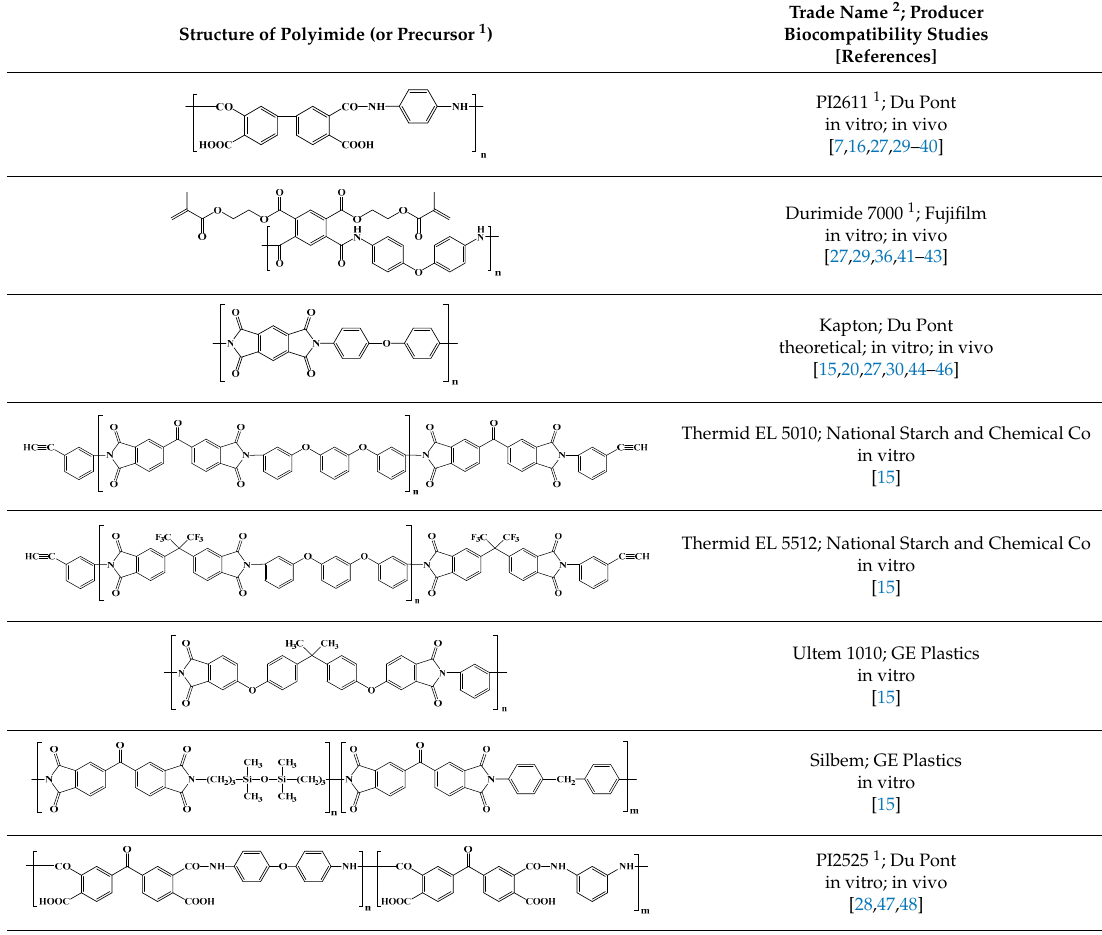
Table 1. Structure, trade name, and producer of commercial polyimides (or precursors) tested for their biocompatibility.